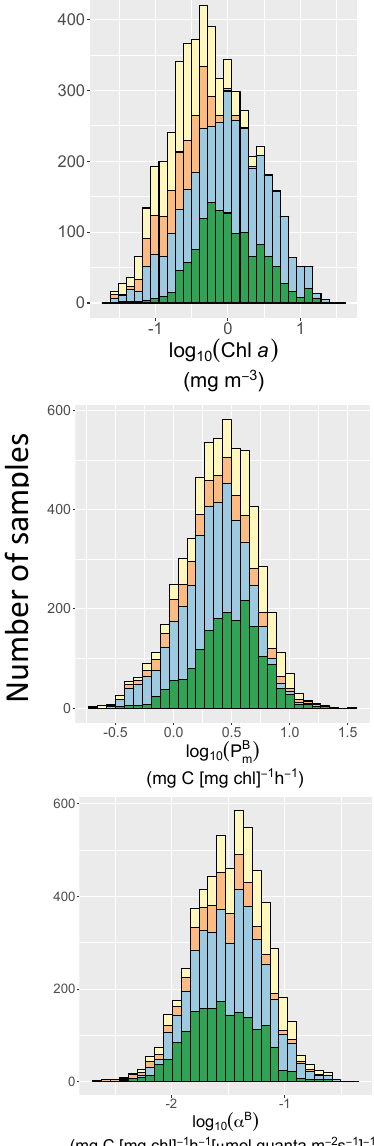
Figure 6. Histograms illustrating the sample distribution across concentrations of chlorophyll a and range of P - E parameter values for the four Longhurst oceanic